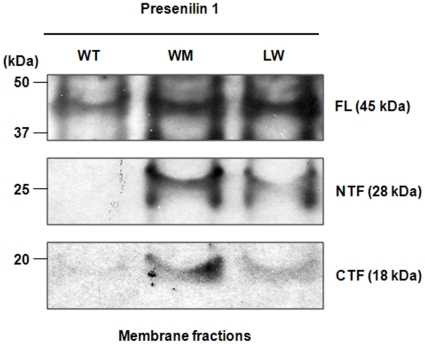
Western blot analysis of PS-1 in fibroblasts from LND patients.WT cells demonstrate very low levels of PS-1 processing to the N- and C-terminal fragment (NTF and CTF, respectively). In both LND cells, processing to both the NTF and CTF proteolytic products is markedly increased compared with that seen in HPRT-positive control WT human fibroblasts.